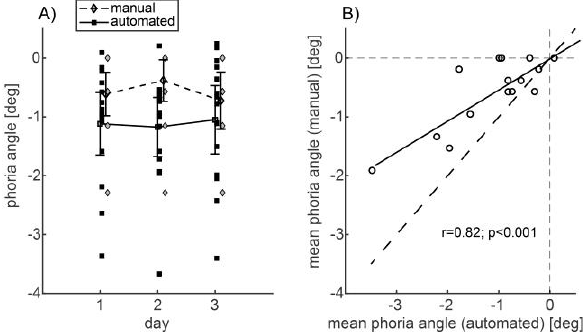
Figure 2: A) ANOVA plot of the phoria angle dependent on the factors day (1-3) and method (automated alternating cover test (squares and solid lines), manual prism cover test (diamonds and dashed lines)). Lines and error bars: means across subjects and the 95% confidence interval of the means. The manual test yielded smaller exophoria measurements than the automated test. B) Scatter plot of the paired measurements. Dashed: line with slope one. Solid: linear regression (slope 0.53). The underestimate of exophoria by the manual prism cover test increased linearly with the phoria